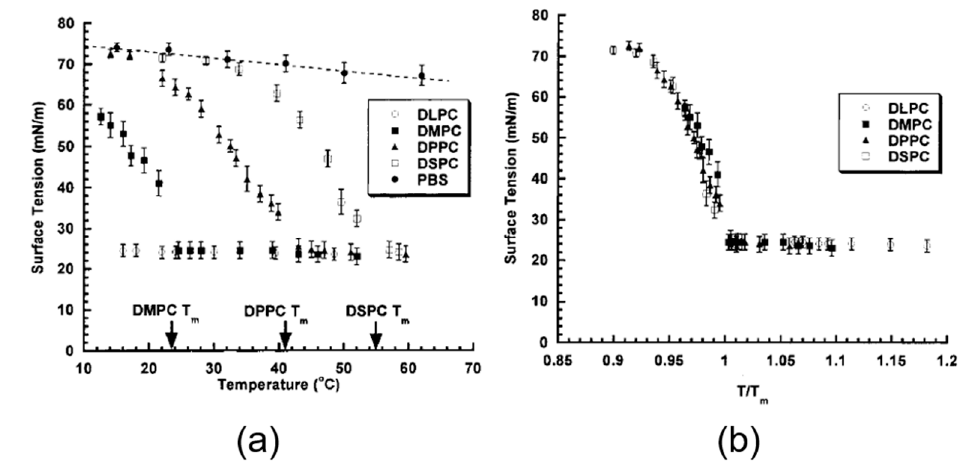
Figure 18. Equilibrium surface tension of four different phospholipids, i.e., dilauroyl- phosphatidylcholine (DLPC), dimyristoyl-phosphatidylcholine (DMPC), dipalmitoyl-phosphatidylcholine (DPPC) and distearoyl-phosphatidylcholine (DSPC) monolayers. ( a ) Equilibrium surface tension of each phospholipid monolayer at each temperature. Arrows mark the gel-to-liquid crystalline phase transition temperature for each phospholipid. (b ) The equilibrium surface tension values are plotted as a function of their relative phase transition temperature (T/T m ), and the behaviour is collapsed to a single curve. Reproduced from Lee et al. [6], with permission from American Chemical Society.